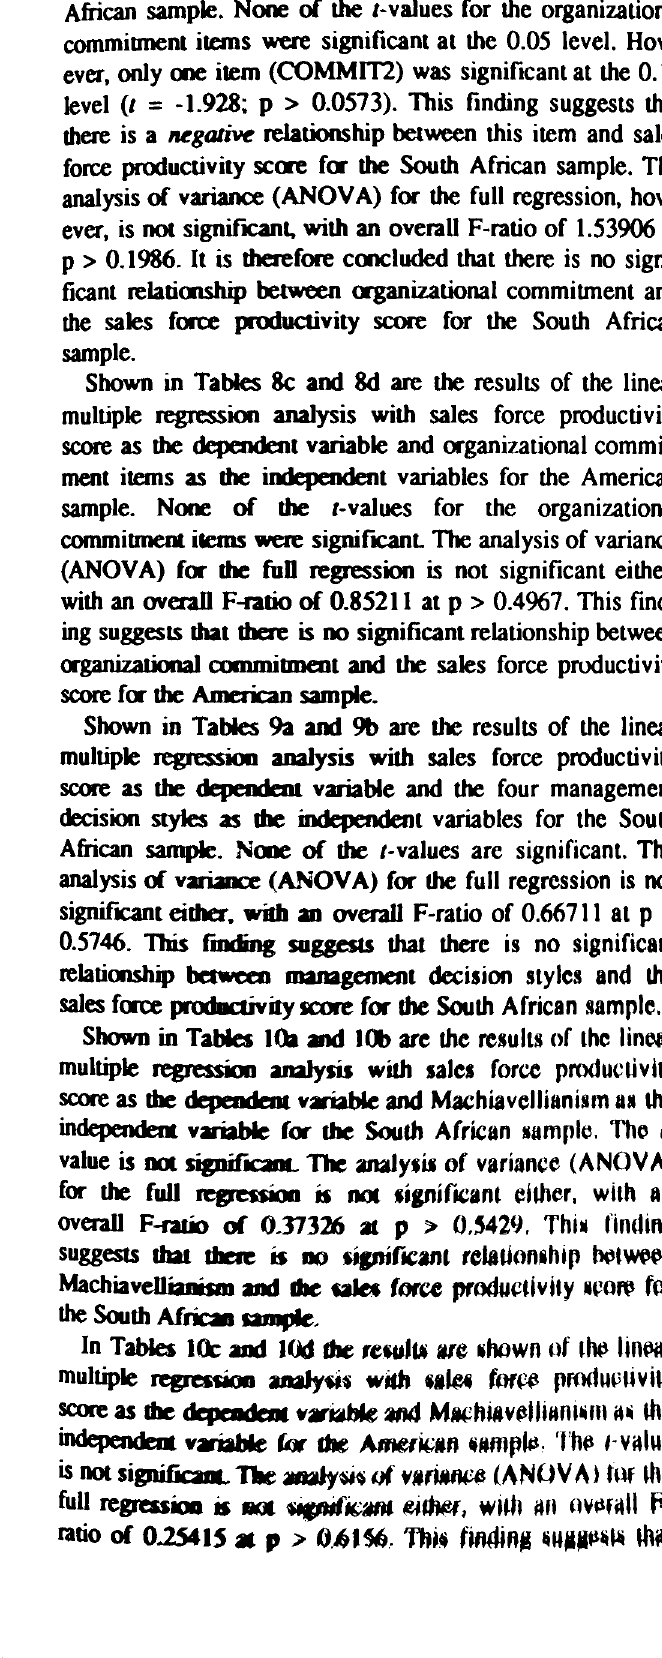
Table 9b Analysis of variance for the full regression -